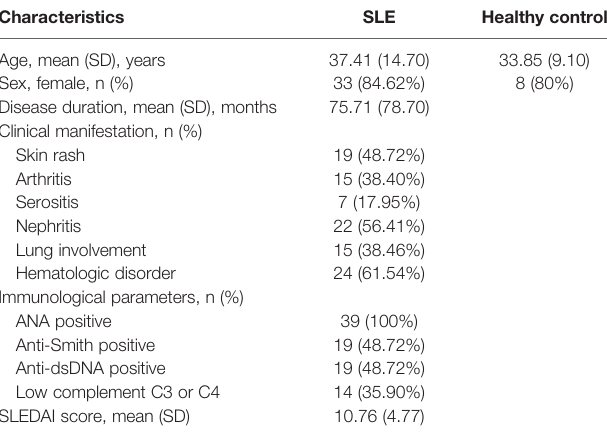
TABLE 1 | Demographic and clinical features of the enrolled SLE